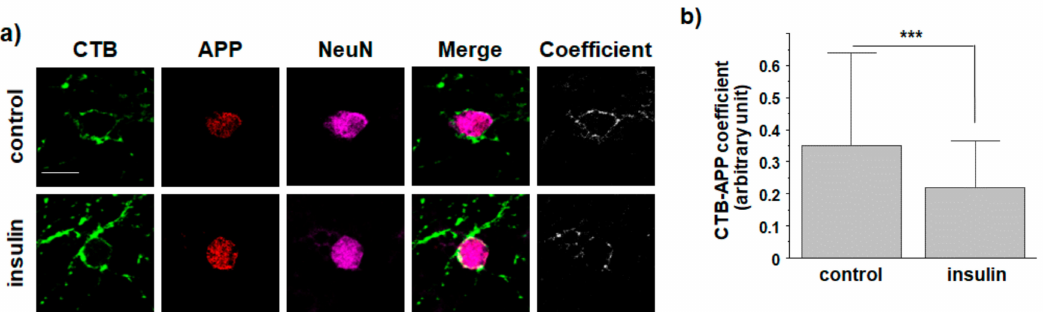
Figure 5. Insulin reduces the localization of endogenous APP in lipid raft microdomains from rat primary hippocampal neurons. Cultured hippocampal neurons were treated with 1 µ M insulin for 2 h in neurobasal media, and then incubated with cholera toxin B (CTB) and 6E10 antibody at 4 ◦ C to label lipid rafts and APP at the plasma membrane, respectively. After washing, cells were fixed and incubated with NeuN antibody for 2 h to identify neurons. ( a ) Typical immunoreactivities of CTB and APP are shown. ( b ) Intensities were quantified as arbitrary units with an LSM710 microscope (Zeiss) using Zen software ( n = 30, number of cells were randomly selected from four different experiments). The threshold was automatically set as the 60–100% value. (Mander’s M2 coefficient: control, 0.4548 ± 0.01484; insulin, 0.33535 ± 0.01475; fraction of B overlapping A, image A: CTB, image B: APP). Scale bar is 10 µ m. One-way ANOVA: ***, p < 0.001. All values represent the mean ±